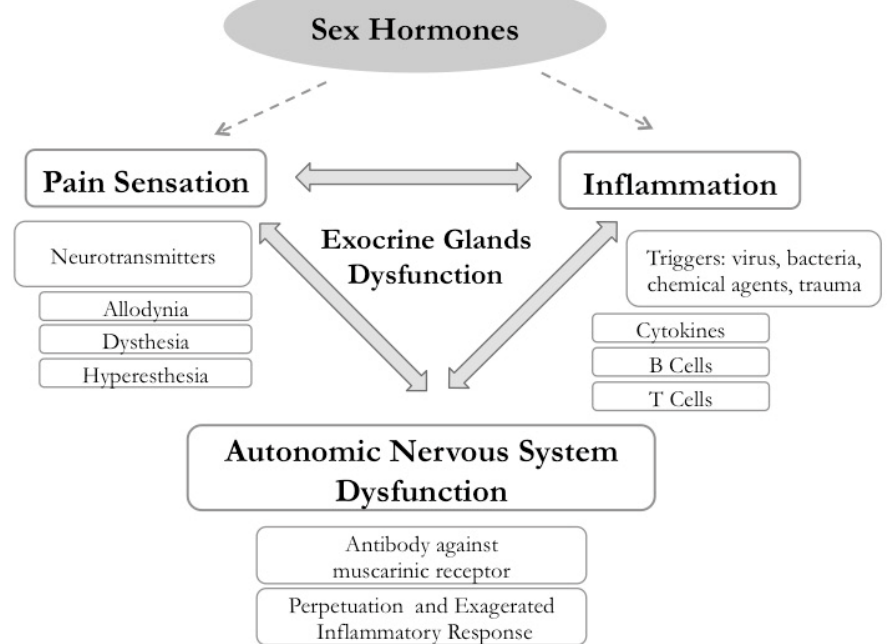
Figure 2. Schematic model showing the interrelationships among autonomic nervous system dysfunction, pathological pain and chronic inflammation in Sjögren’s syndrome (SS) [19,29]. The dotted arrows indicate the effects of hormones with all their cyclic, indirect and also circadian influences. The gray two-way arrows indicate the interdependence of the three phenomena highlighted in the boxes: pain sensation, inflammation and autonomic nervous system dysfunction.